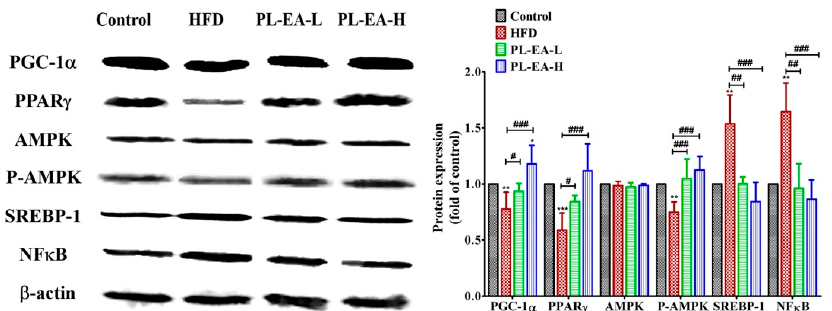
control (right panel) showing alterations among groups. HFD: high-fat/high-fructose diet